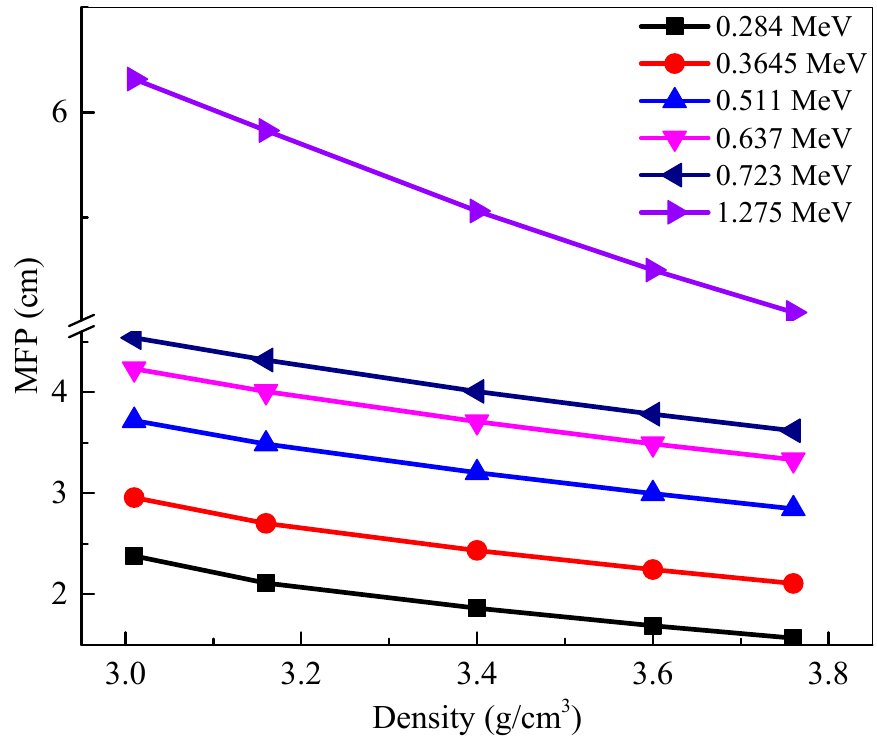
Figure 6. The mean free path ( MFP ) of the shielding samples vs. the density.